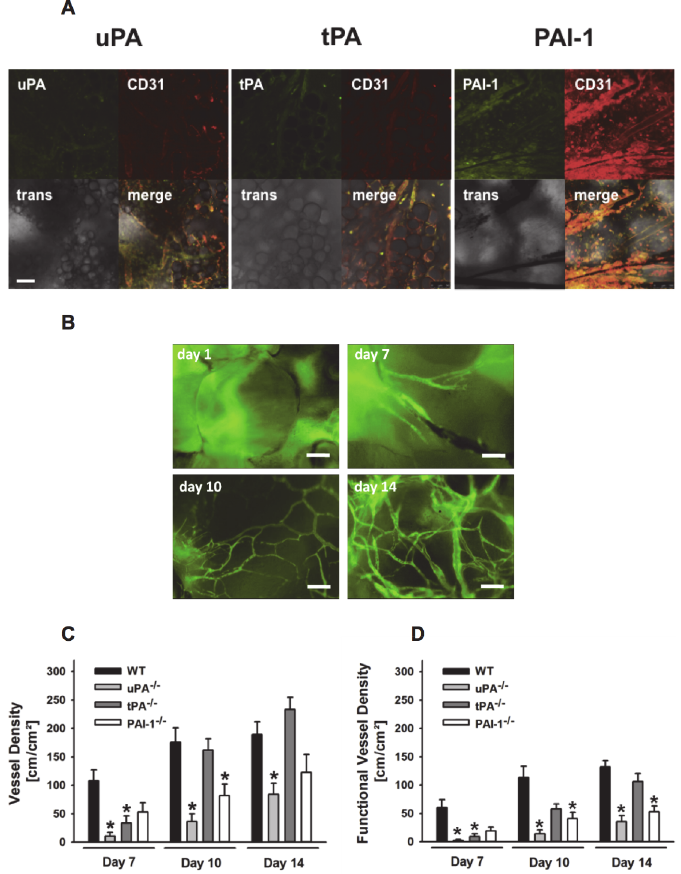
Figure 1. Role of endogenous uPA, tPA, and PAI-1 for vascularization of PPE biomaterial. The distribution of uPA, tPA, and PAI-1 in engrafted PPE biomaterial was analyzed ex vivo in implants from WT mice by confocal microscopy ( A; scale bar: 100 μ m). Vascularization of PPE implants was analyzed in WT as well as in uPA-, tPA-, or PAI-1-deficient mice by in vivo fluorescence microscopy. Representative in vivo microscopy images of PPE biomaterial vascularization in a WT mouse are shown ( B ; scale bar: 100 μ m). Panels show results for the absolute ( C ) and functional ( D ) vessel density within the implant (mean ± SEM for n = 6; * p < 0.05 vs.